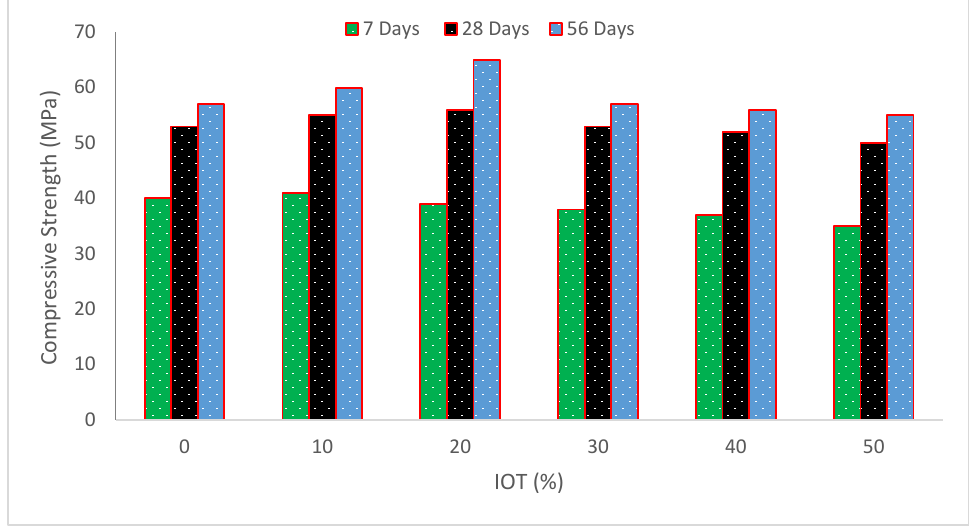
Figure 8. Compressive strength of concrete (data source [36]).